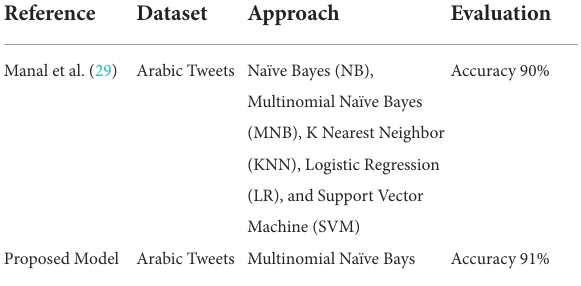
TABLE 5 Comparative analysis of the proposed model with state-of-the-art